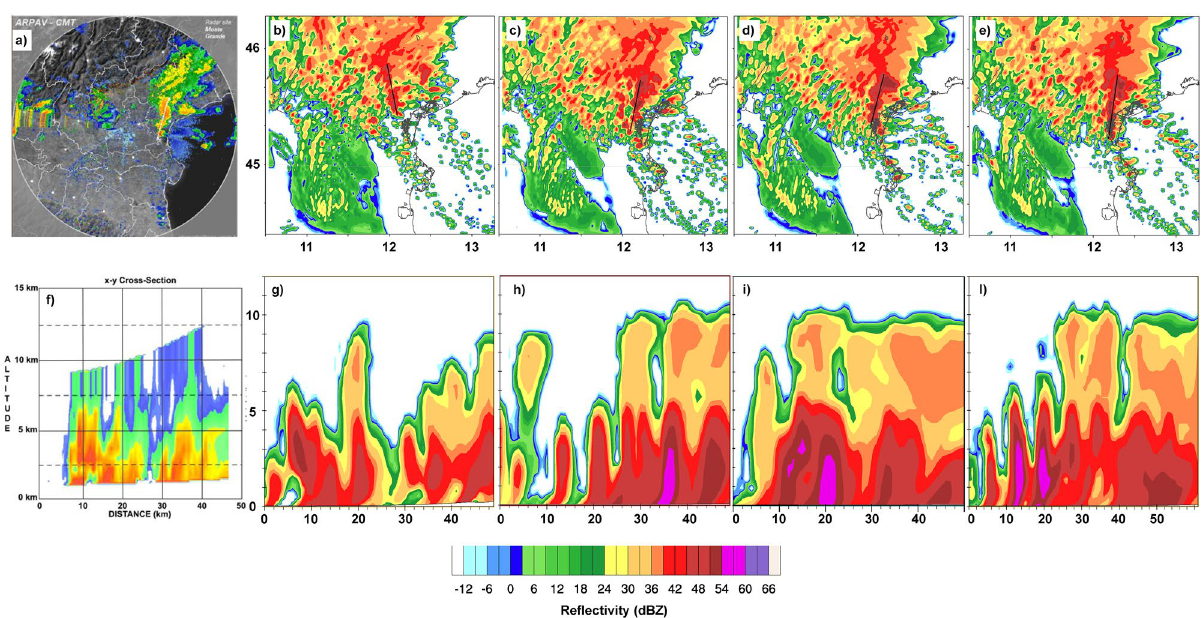
Figure 5. Upper row: ( a ) 2-D radar reflectivity data (Vertical Maximum Intensity) in the HPE region; synthetic radar data simulated in ( b ) RTG, ( c ) ROMS, ( d ) AO and ( e ) AOW; ( f ) cross section of the storm radar reflectivity acquired by the radar in Teolo at 06 UTC, 26 September 2007; ( g )–( l ) reflectivity vertical cross sections along the axes of most intense convection (whose locations are in panels ( b )–( e ) for ( g ) RTG, ( h ) ROMS, ( i ) AO and ( l )